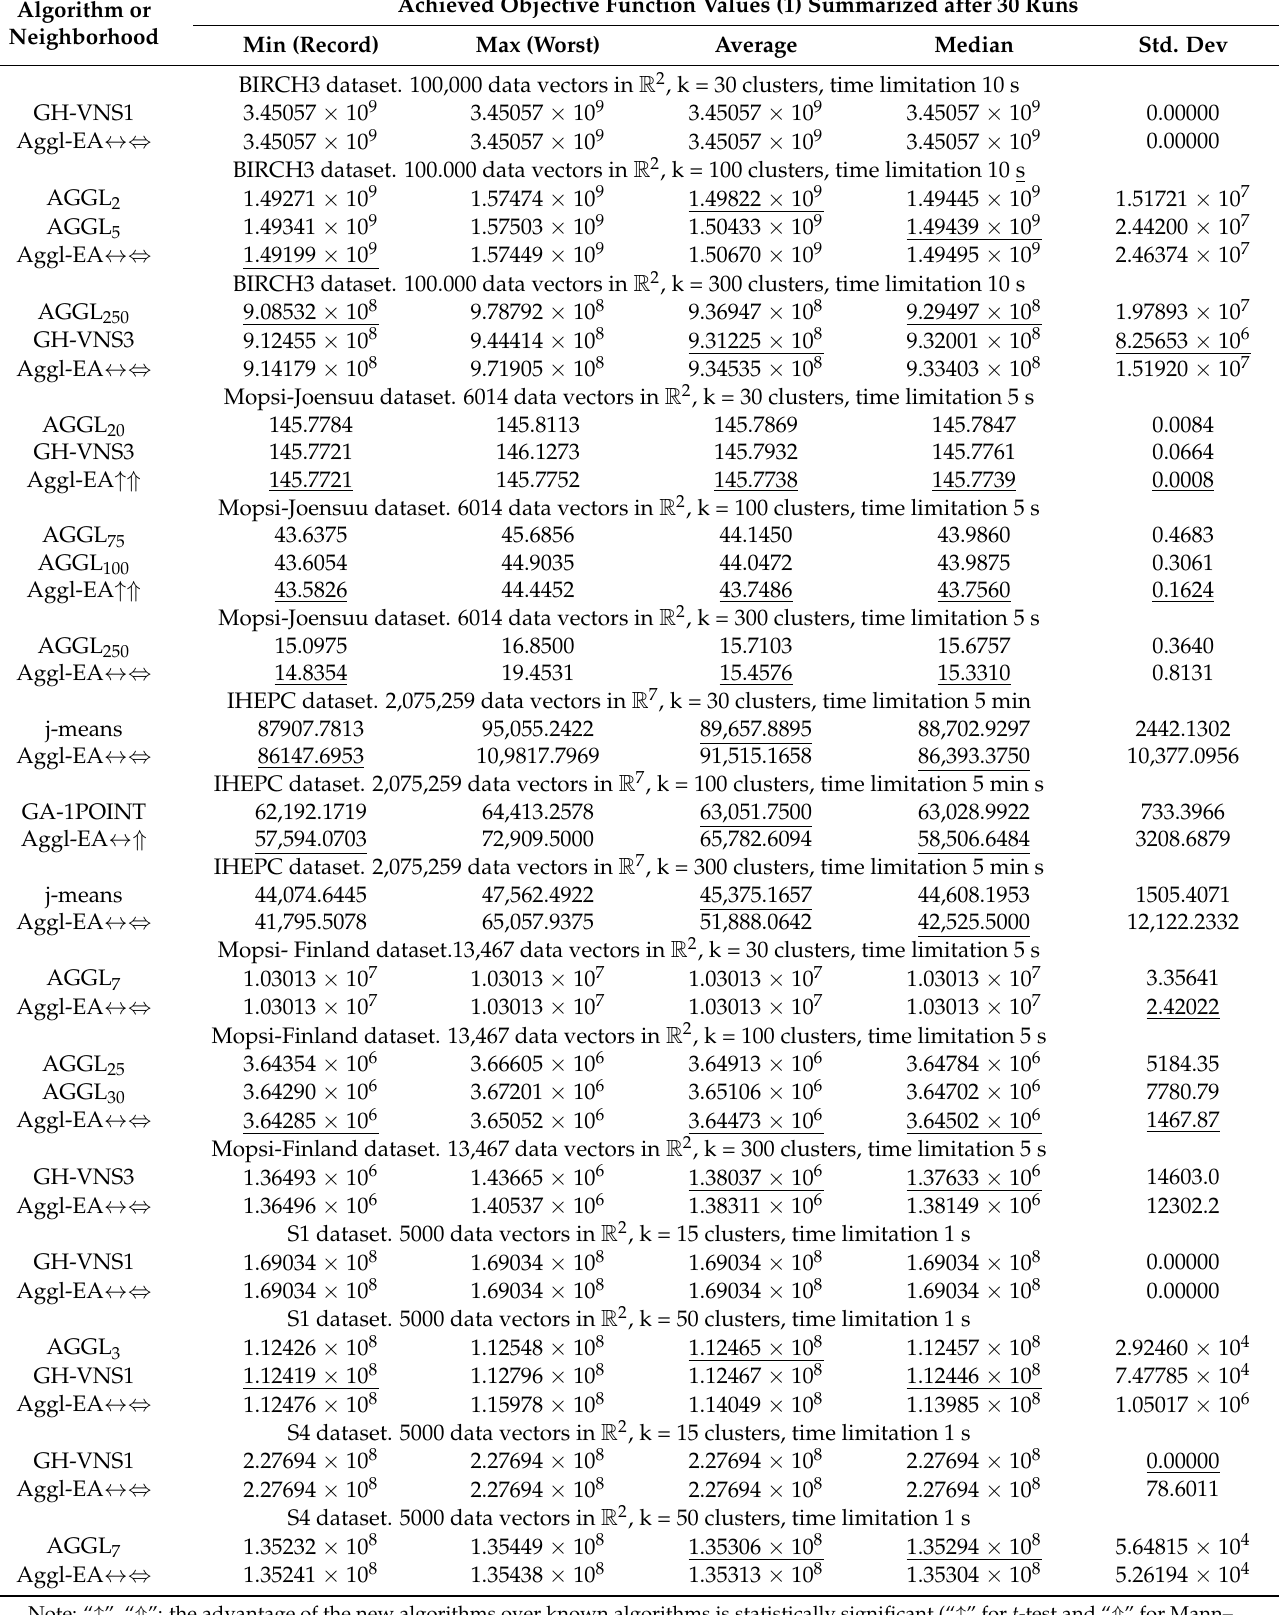
Table 1. Comparative results for all datasets (best of known algorithms vs. new